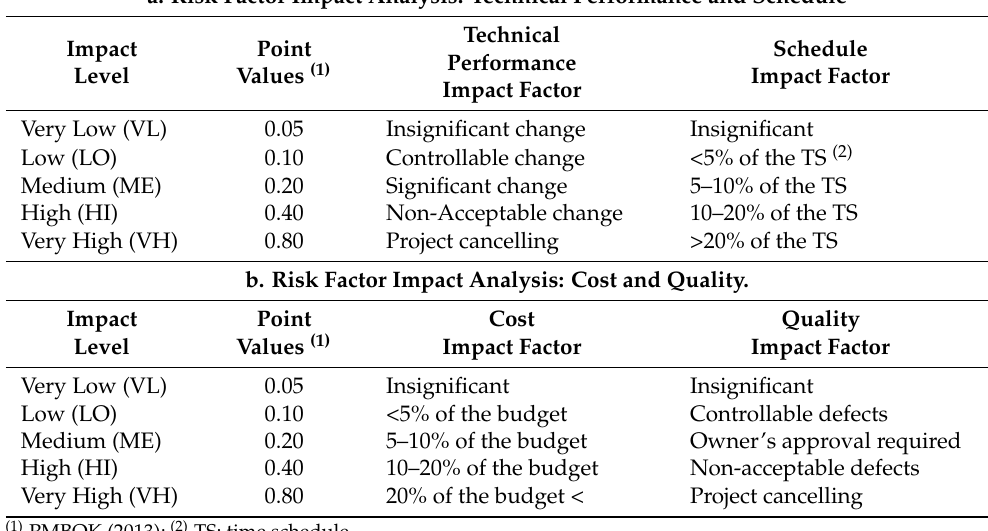
Table 7. a . Risk factor impact analysis: technical performance and schedule; b . risk factor impact analysis: cost and quality.